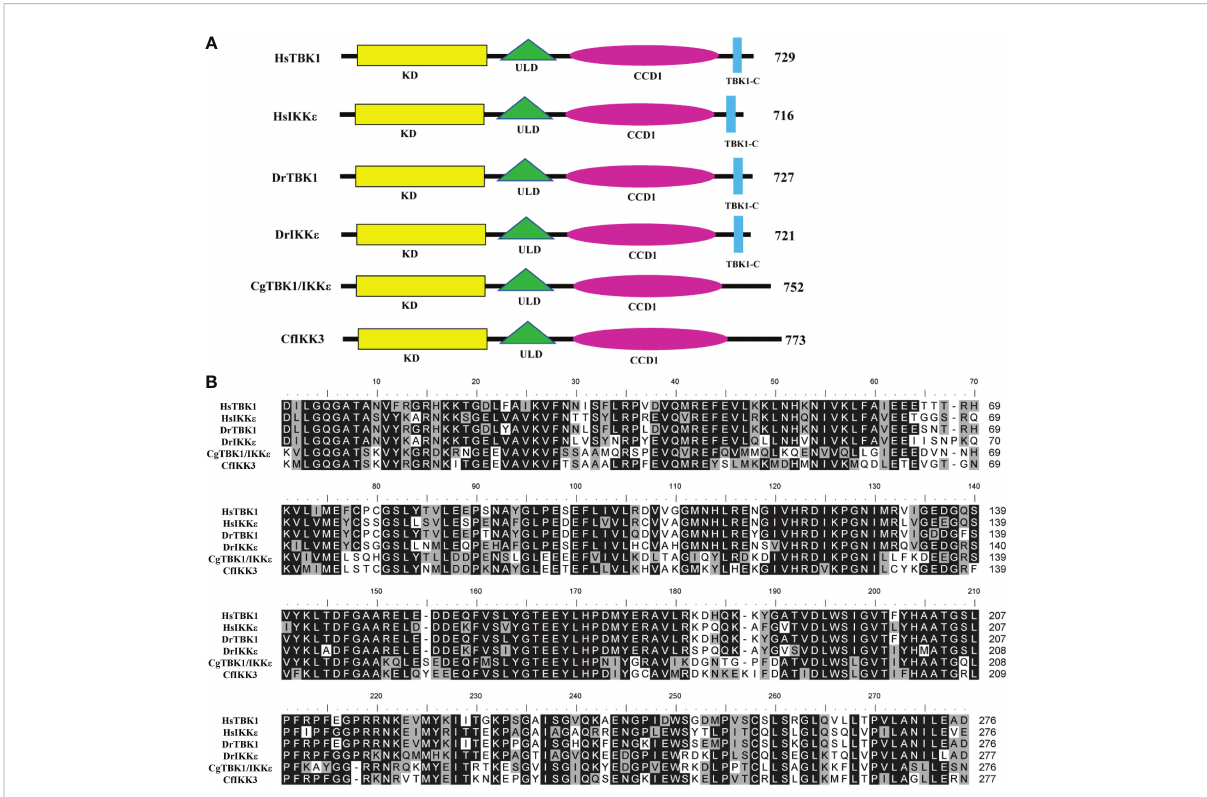
FIGURE 2 Schematic representation of TBK1/IKK ϵ proteins of different species (A) and multiple sequence alignment of the kinase domain of TBK1/IKK ϵ proteins from different species (B) . The GenBank accession numbers for the sequences used are as follows: HsTBK1, NP_037386.1; HsIKK ϵ , NP_054721.1; DrTBK1, NP_001038213.2; DrIKK ϵ , NP_001002751.1; CgTBK1/IKK ϵ , XP_034304979.1. Hs, Homo sapiens ; Dr, Danio rerio ; Cg, Crassostrea gigas ; Cf, Chlamys farreri . KD, kinase domain; ULD, ubiquitin-like domain; CCD1, coiled-coil domain 1. Sequences with identical amino acids are shaded in black, whereas conservative amino acid substitutions are shaded in